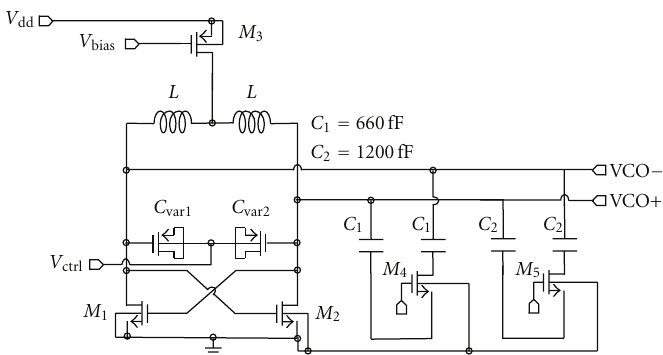
Figure 4: Schematics of core VCO using switched capacitors.